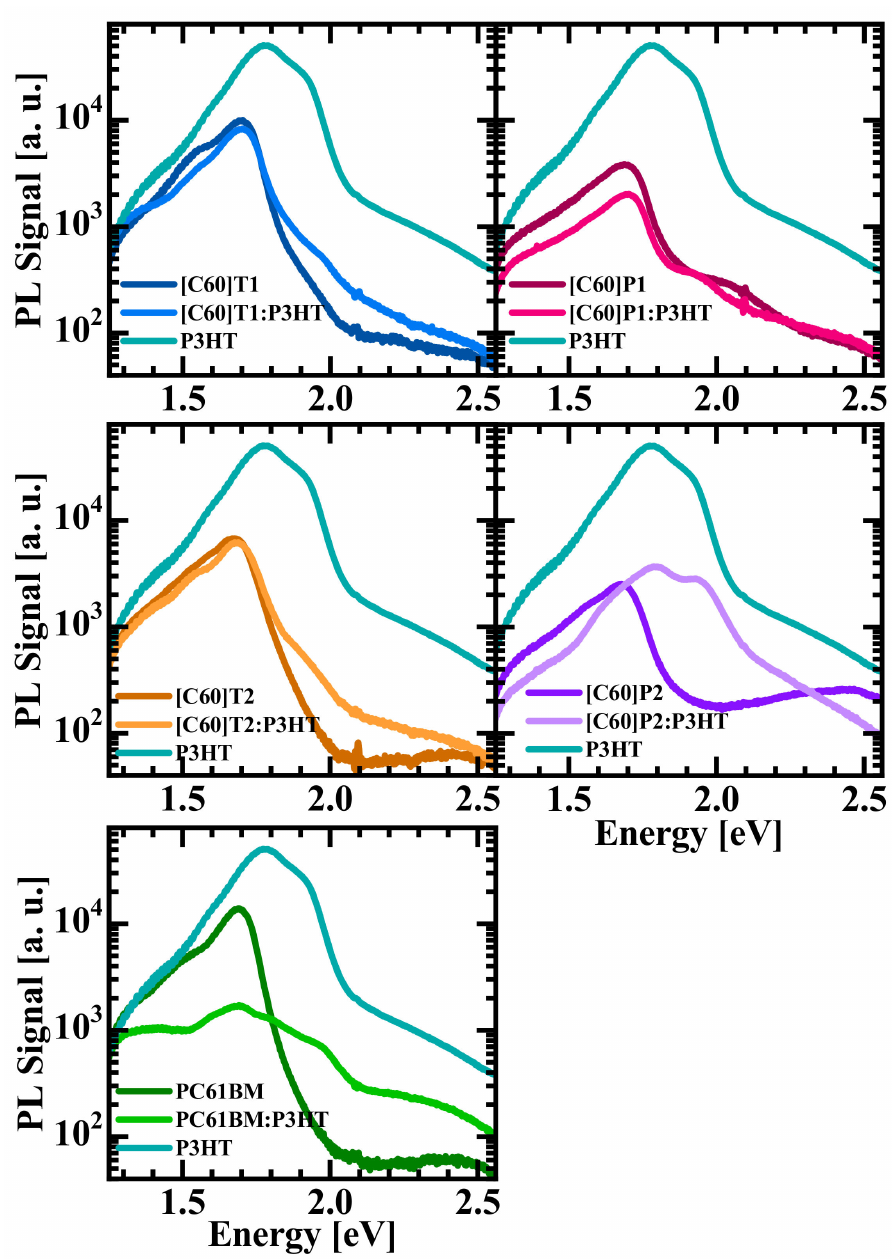
Figure 8. PL spectra of P3HT, fullerene derivative, and their